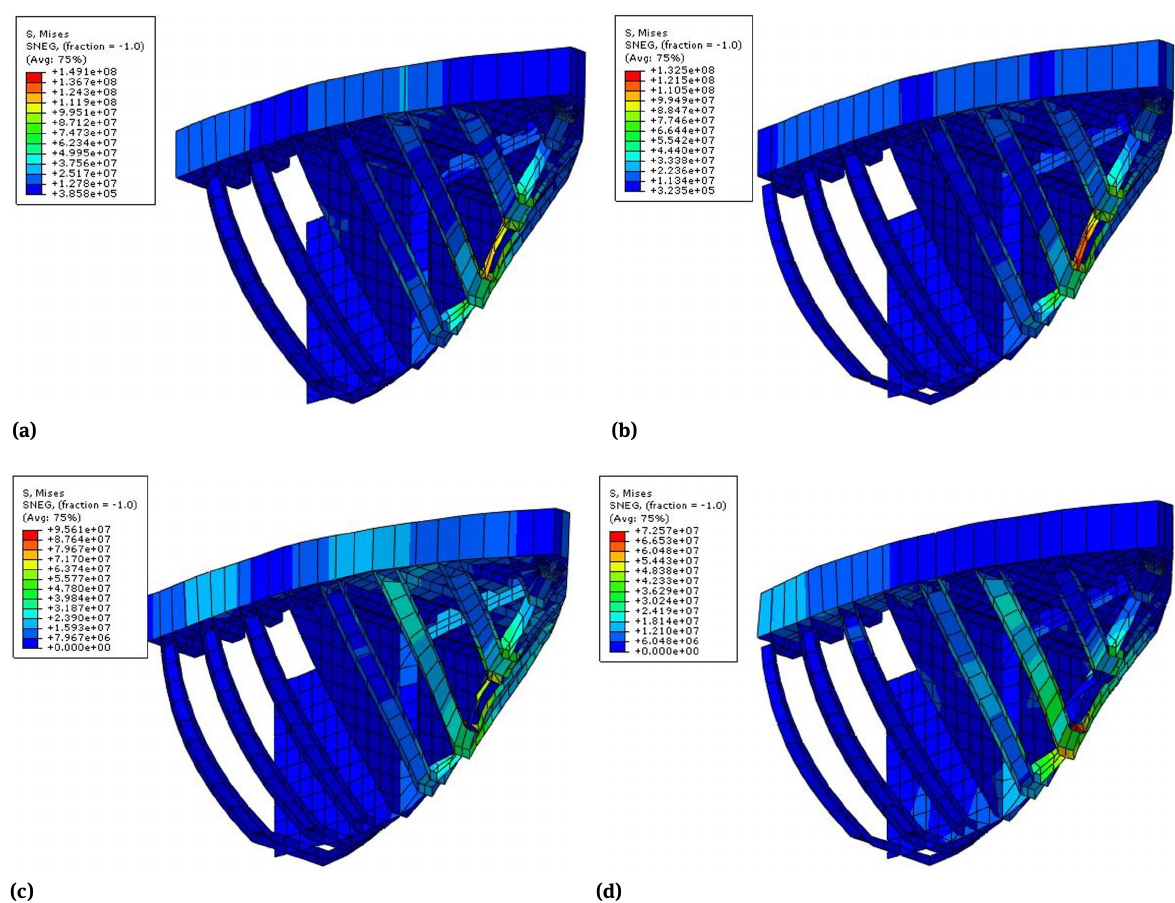
Figure 29: Deformation of bow construction due to impact at a speed of 3 knots: (a) Laminate type 1, (b) Laminate type 2, (c) Laminate type 3, (d) Laminate type